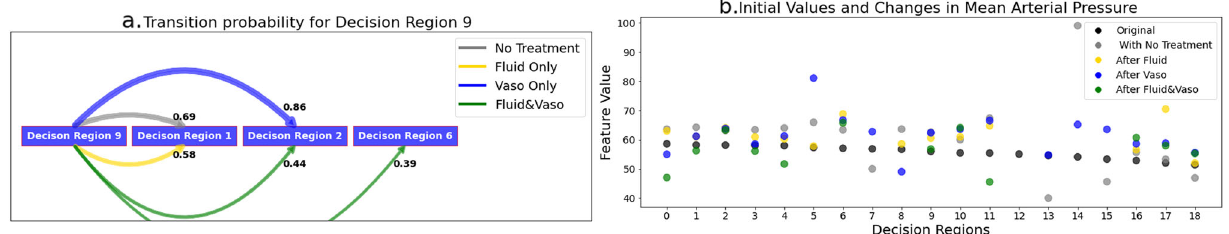
Fig. 4 Change in patient state after different treatments. a The probability of patients moving from one decision region to other decision regions when given different treatments. This example fi gure shows how patients transition out of decision region 9. b The expected average feature value for patients in each decision region after different treatments were given. This example fi gure re fl ects MAP level change.